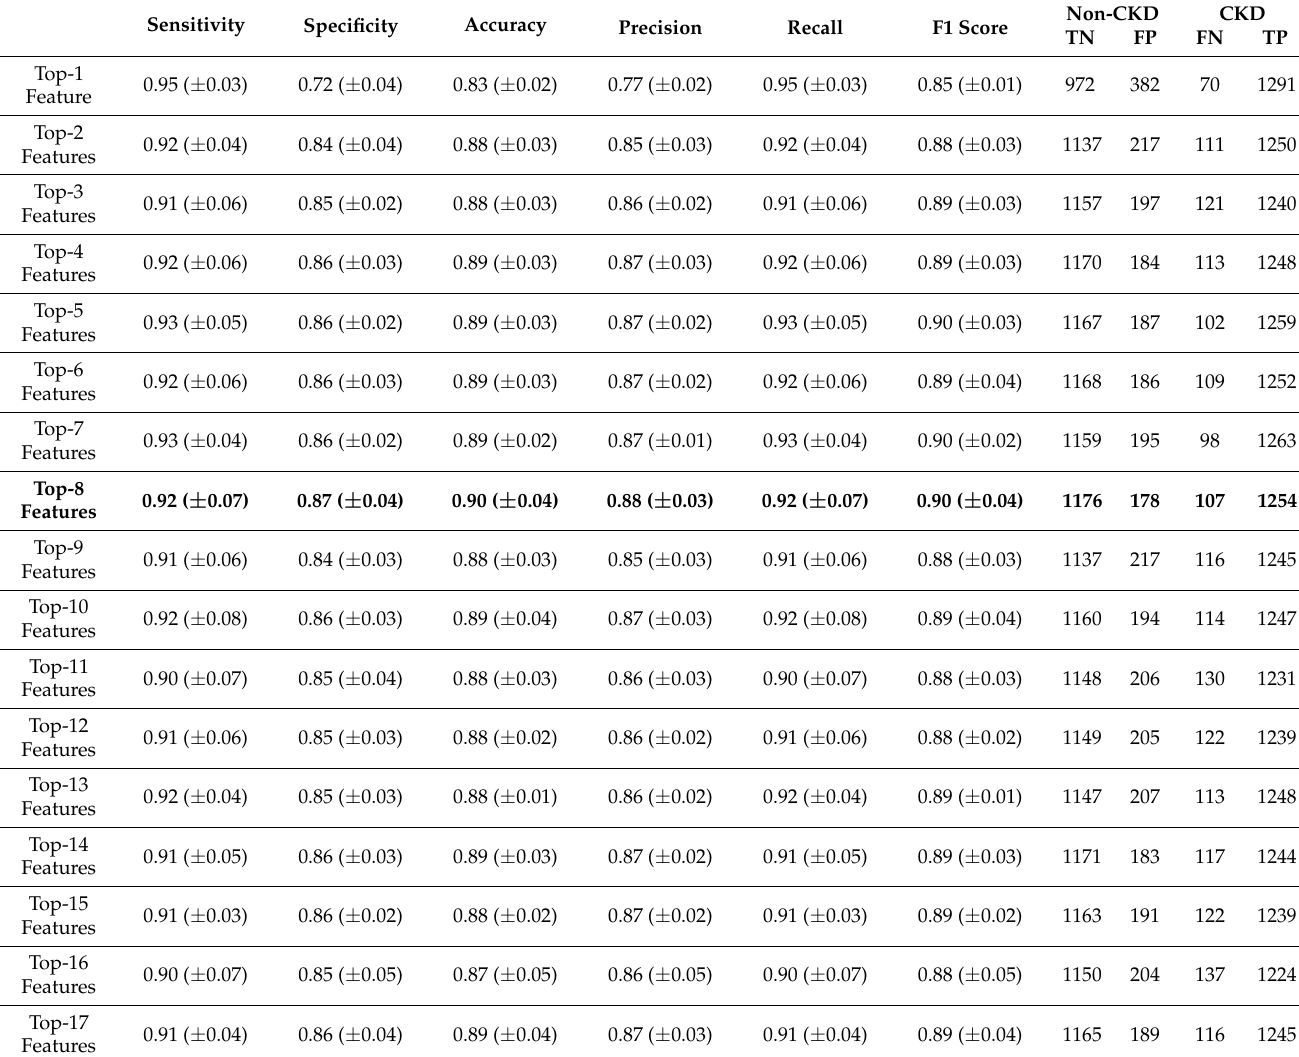
Table 2. Performance analysis of LR models using top-1 to top-17 features from XGB feature ranking